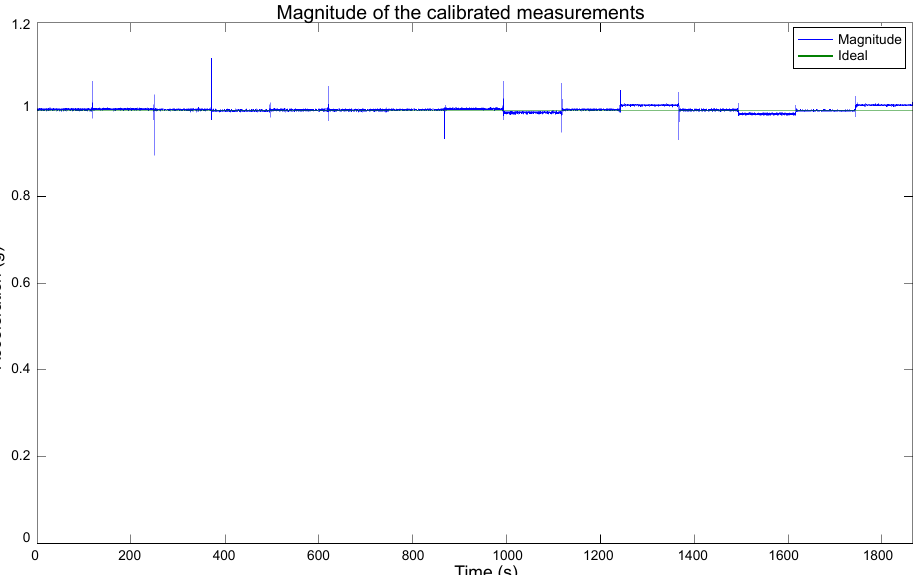
Magnitude Ideal